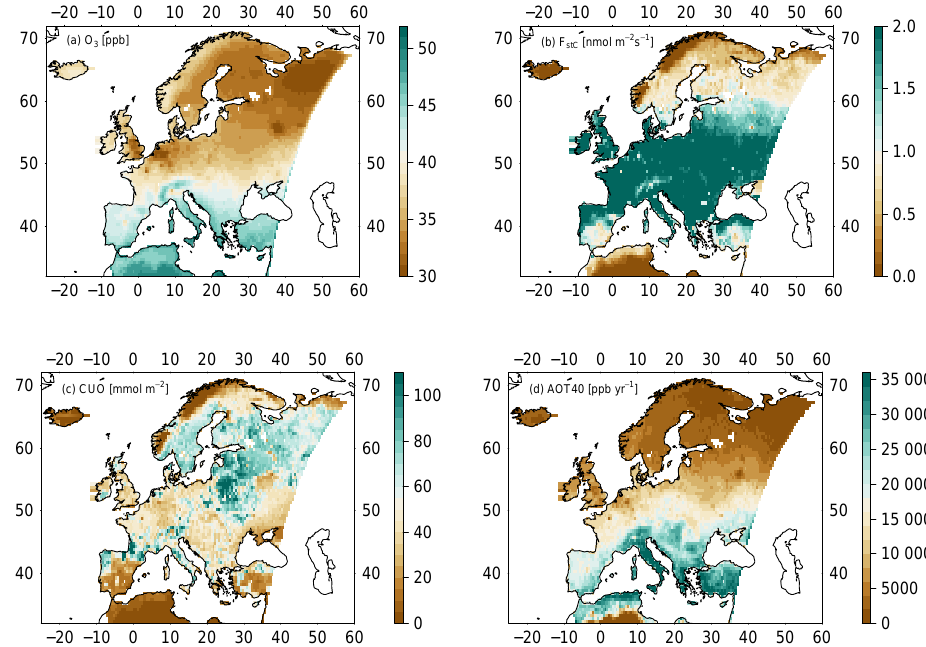
Figure 6. Mean decadal (a) O 3 concentration (ppb), (b) canopy-integrated O 3 uptake into the leaves (nmolm − 2 s − 1 ), (c) canopy-integrated cumulative uptake of O 3 (CUO) (mmolm − 2 ), and (d) AOT40 (ppmyr − 1 ), for Europe of the years